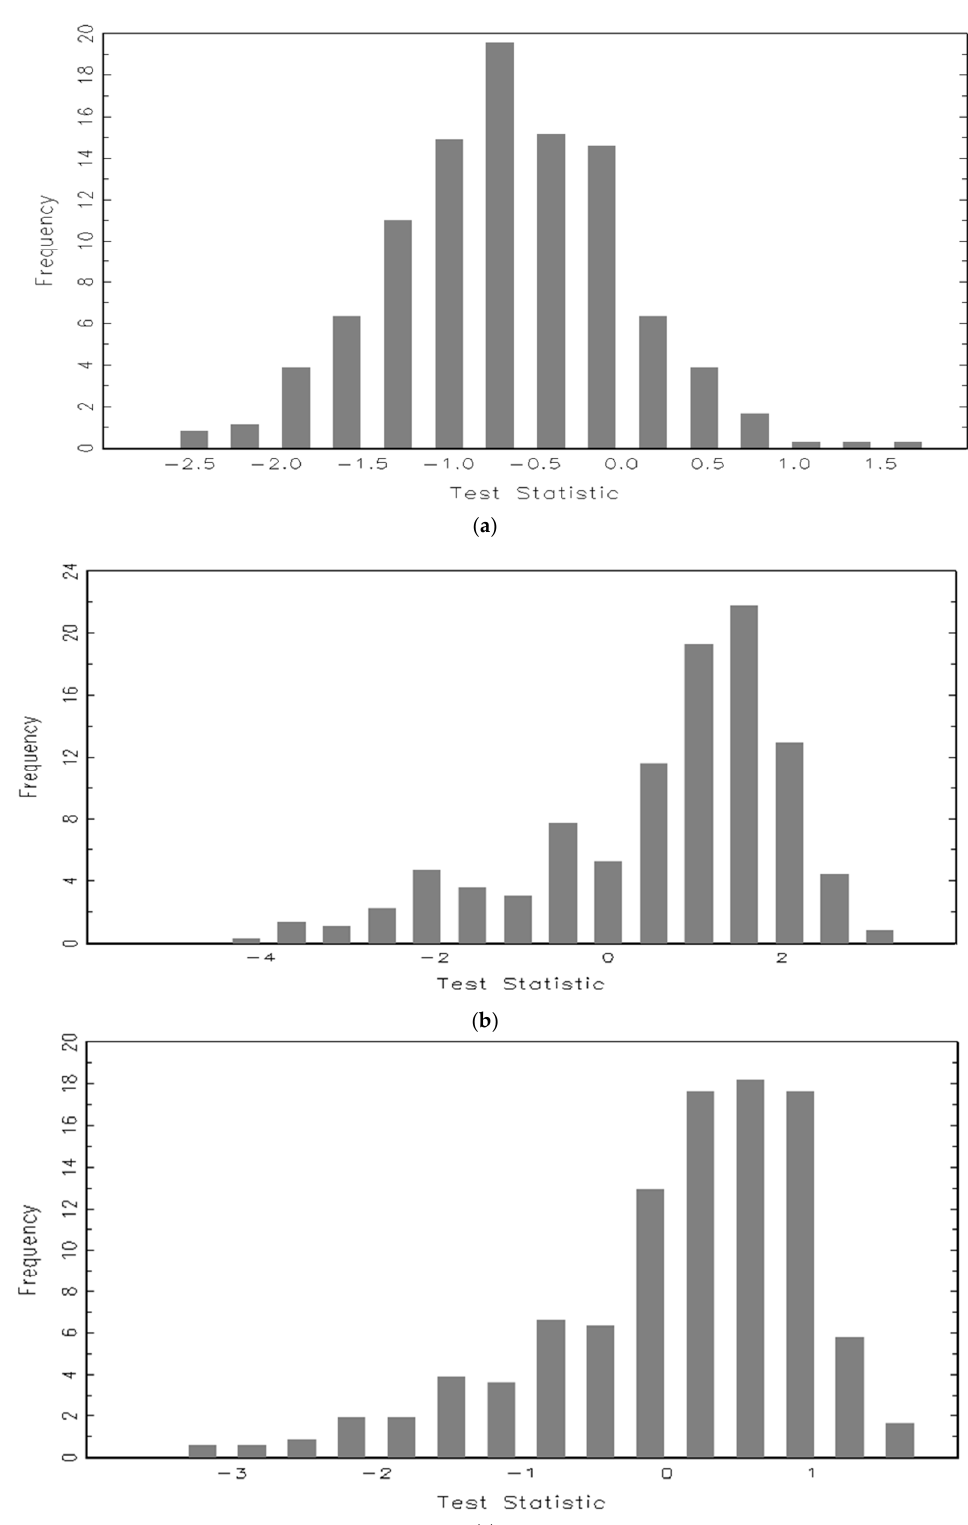
Figure 1. Distribution of the Unconditional Market-Timing Test Statistic. ( a ) Test Statistic of Unconditional Nonparametric Market Timing; ( b ) Test Statistic of Unconditional TM Market Timing; ( c ) Test Statistic of Unconditional HM Market Timing.